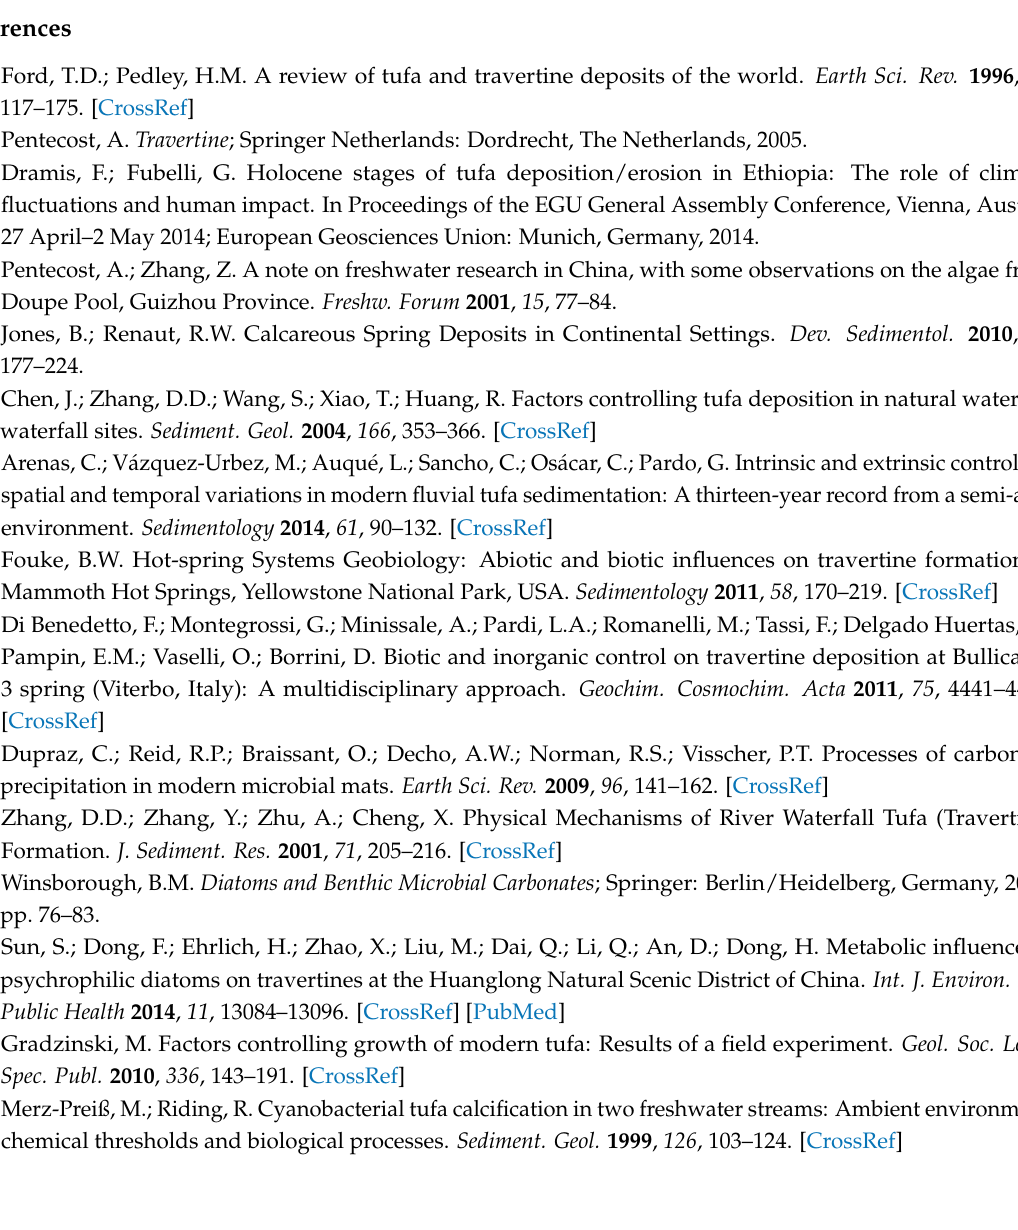
Figure S1: (a) X-ray diffraction (XRD) spectrogram and (b) Energy dispersive spectrum (EDS) diagram of tufa samples, Table S1: The major water parameters of the studied